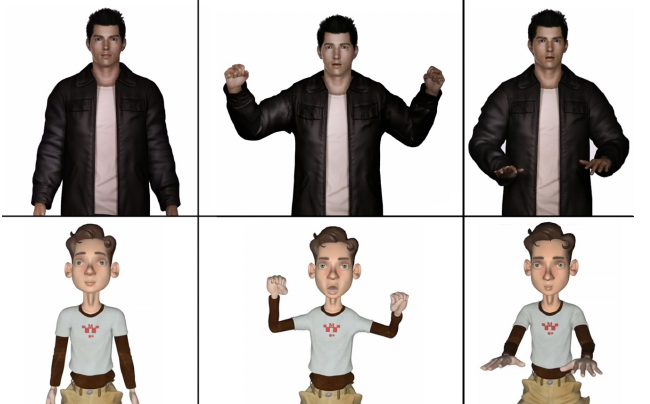
Figure 4. Three frames extracted form the animation featuring the realistic character (top), and three frames extracted from the animation featuring the stylized character